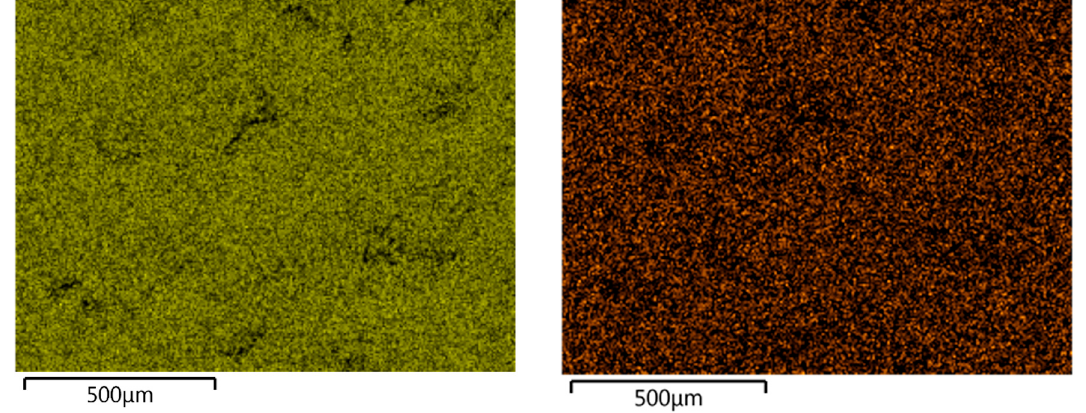
Figure 13. SEM / EDS images of the obtained Figure 13. SEM/EDS images of the obtained precipitate.